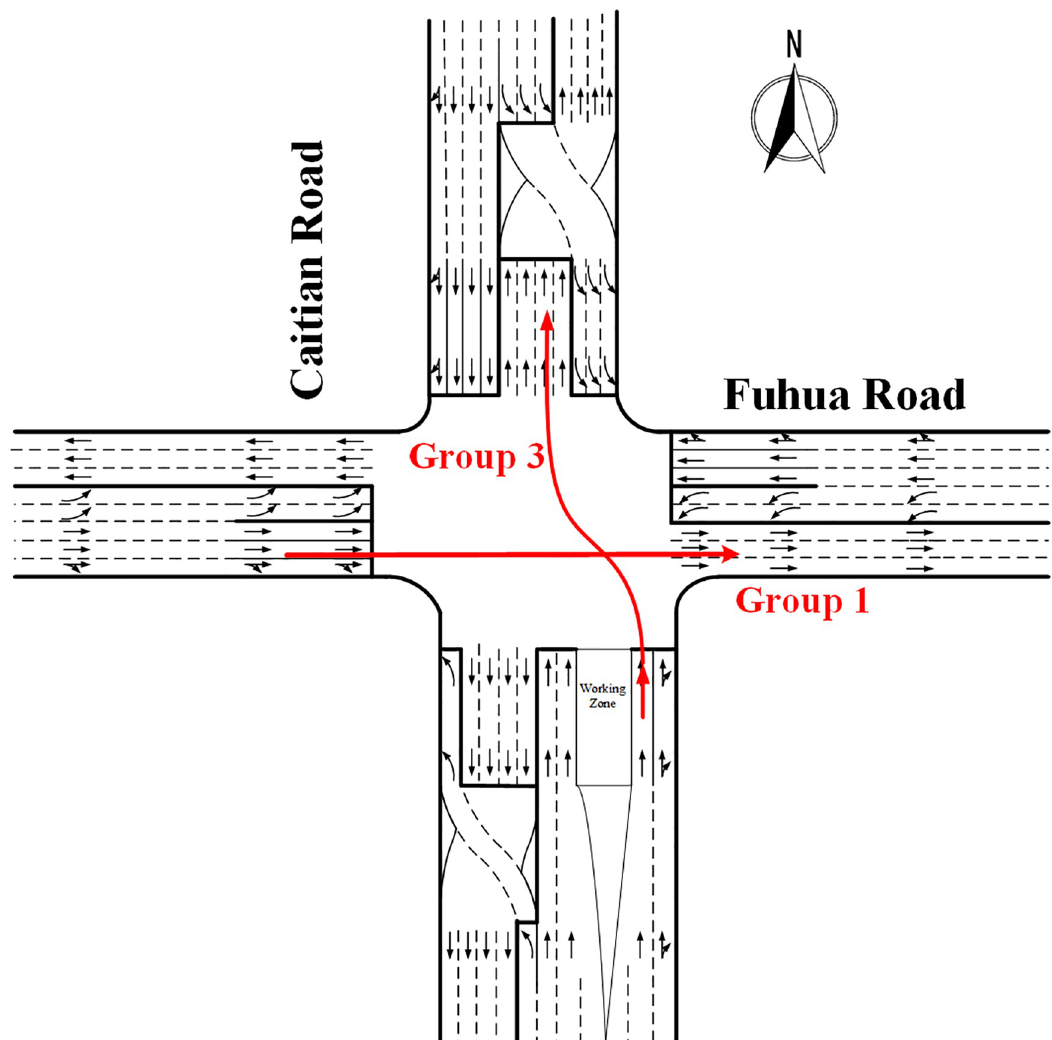
Fig 5. Lane offset of through movement at the CFI approach.